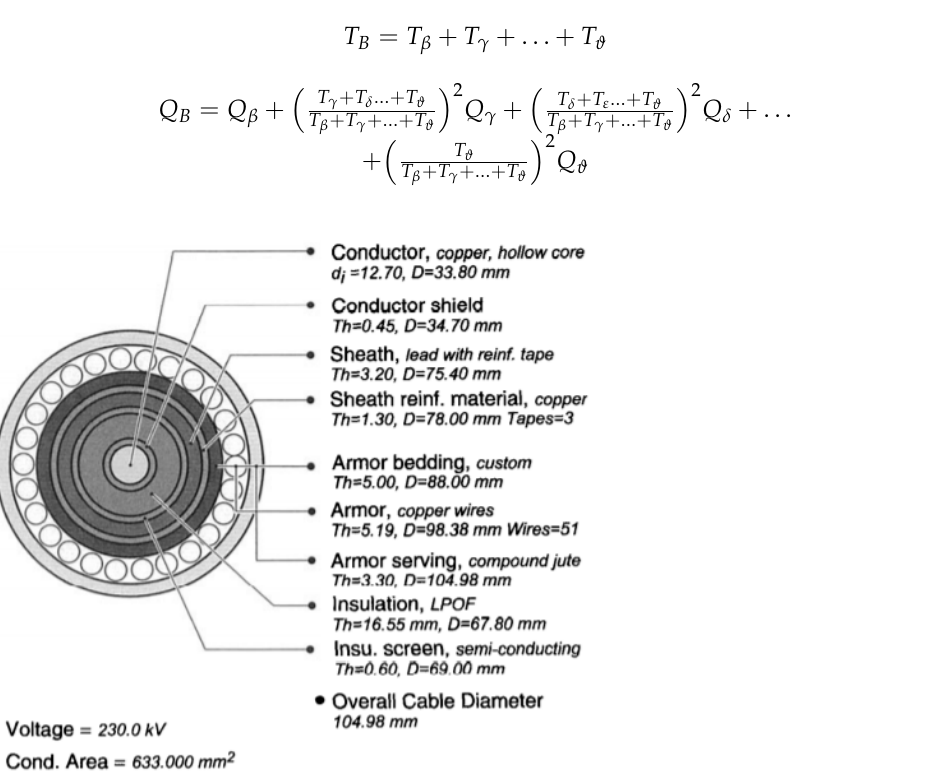
Figure 1. Cable system parameters.